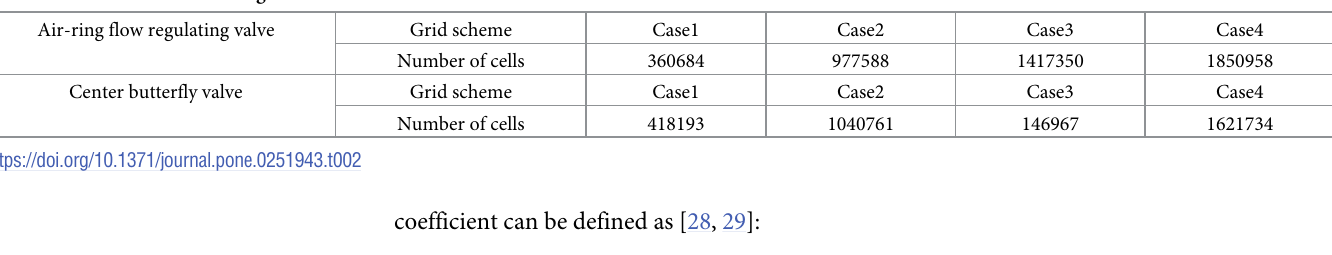
Table 2. Parameters of different grid schemes.